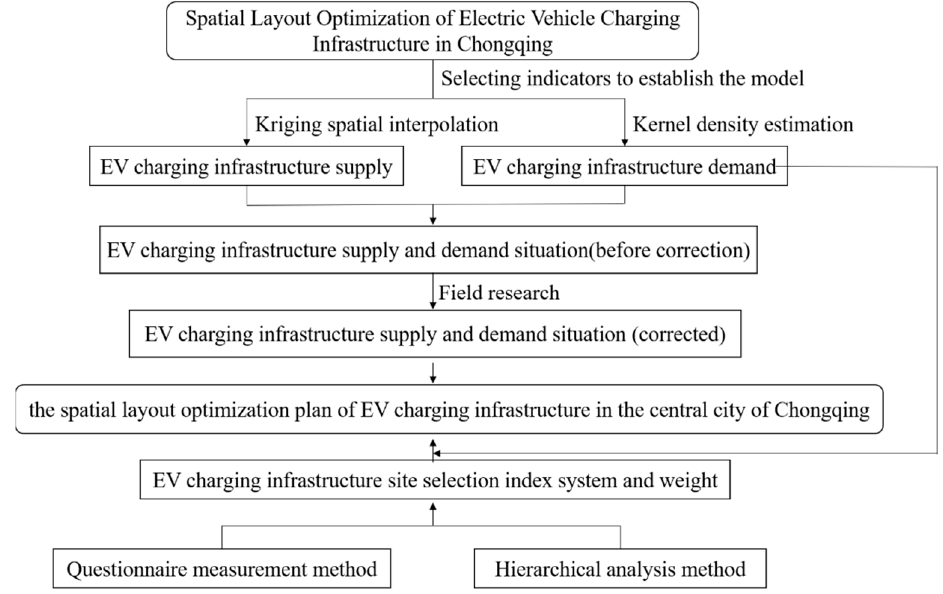
Figure 2. Research